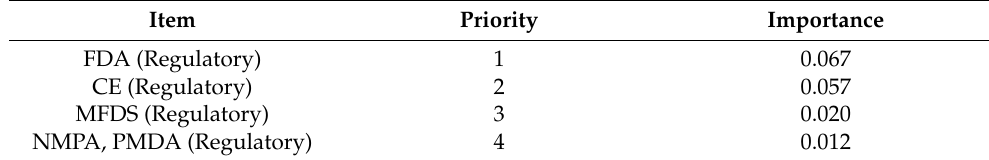
Table 4. Results of regulatory readiness.